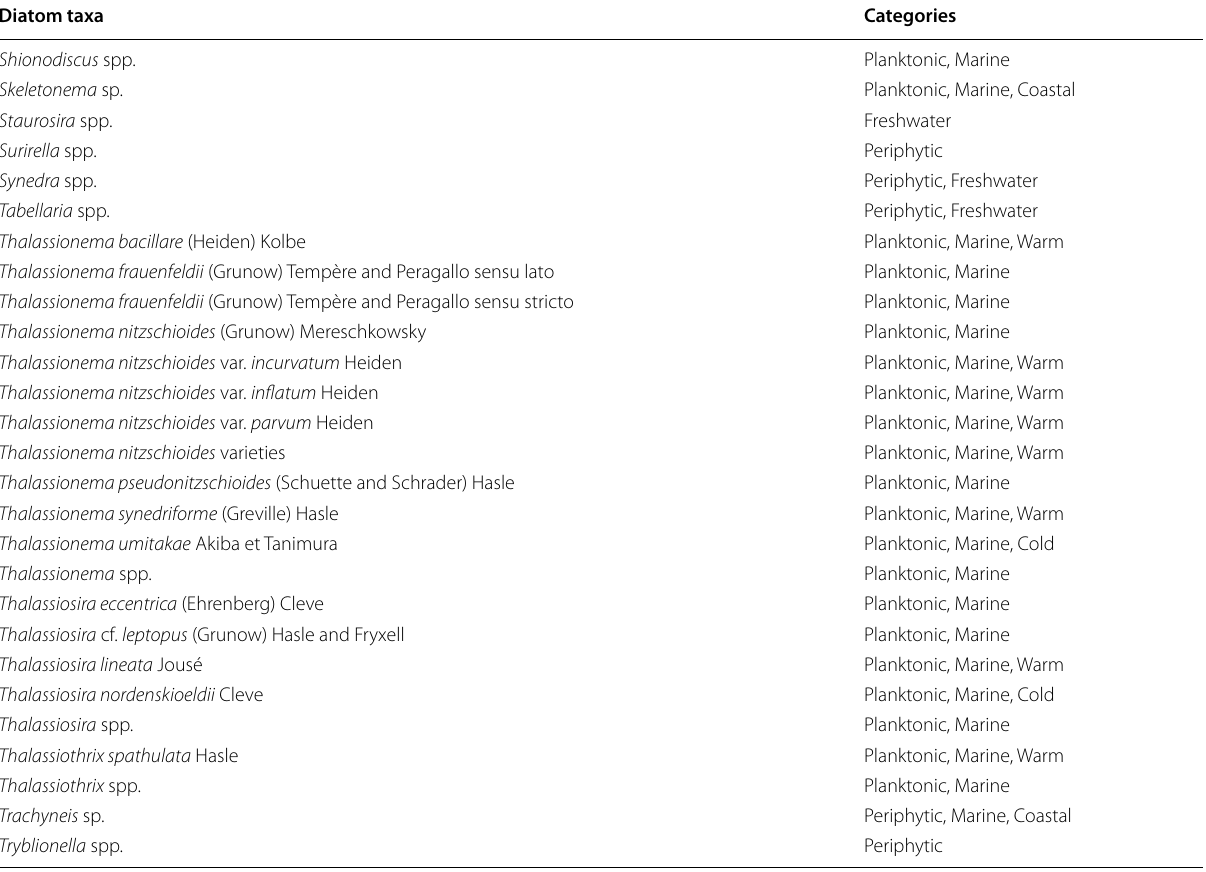
(Fig. 3). Morphological varieties of Thalassionema nitzs- chioides were persistently high percentages throughout the core. Among the T. nitzschioides varieties, three vari- eties (var. incurvatum , var. inflatum , and var. parvum ) increased during the middle-late Holocene. On the other hand, Thalassionema frauenfeldii sensu stricto (s.s.) and Thalassionema synedriforme were relatively high during the deglacial